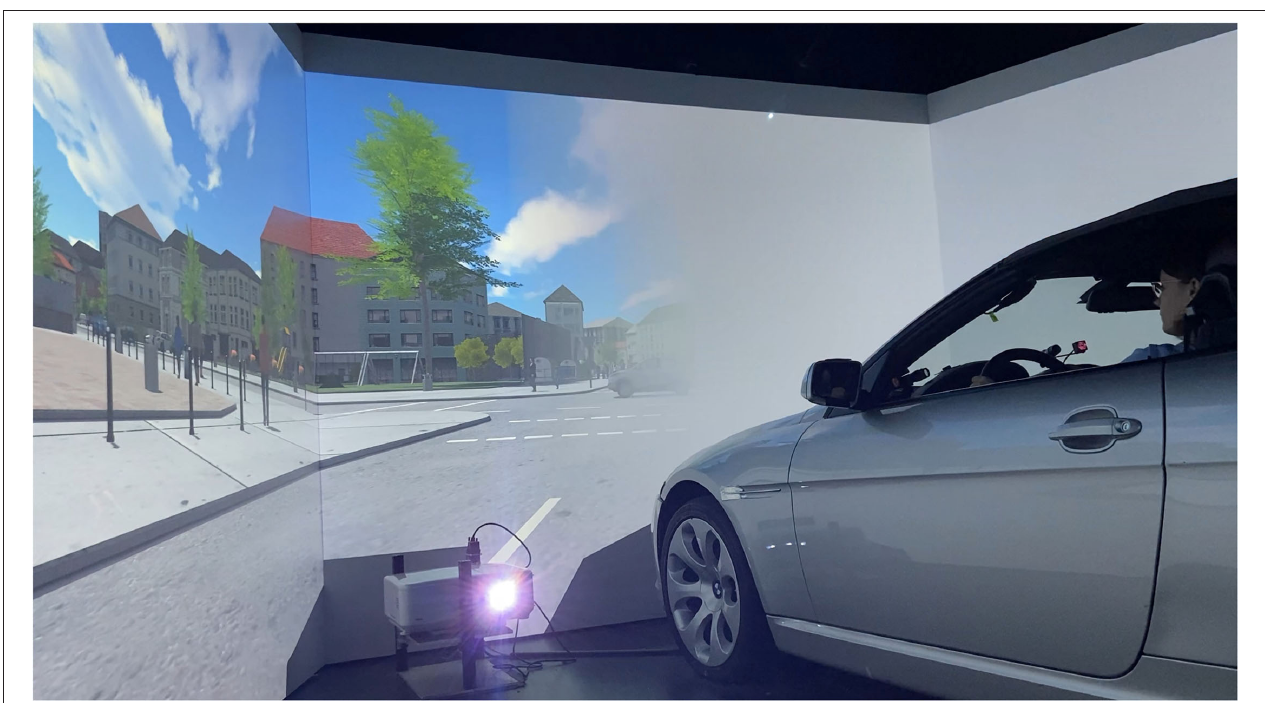
FIGURE 1 | The study was conducted in a static driving simulator, which consists of a BMW mock-up and a 180 ◦ frontal field of view. Complete homonymous hemianopia on the left and right side was simulated on large screens with a semi-transparent transition toward the seeing side and a match of color and luminance of the occluding mask to the road surface and surrounding